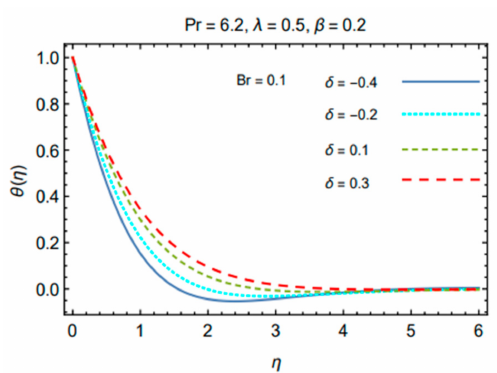
Figure 7. Variation in θ ( η ) against δ .